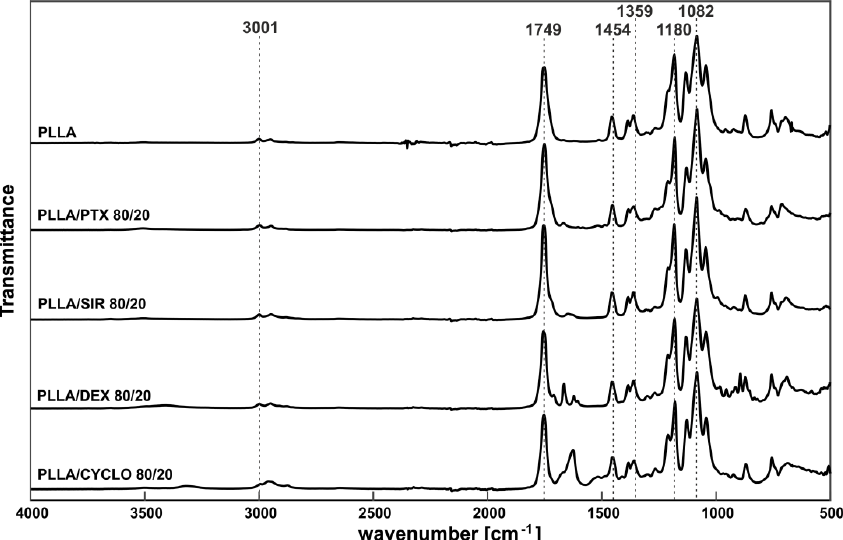
Figure 2. IR spectra of PLLA film and PLLA films with 20 w / w % incorporated drugs. IR bands of PLLA have been identified with reference to [51].